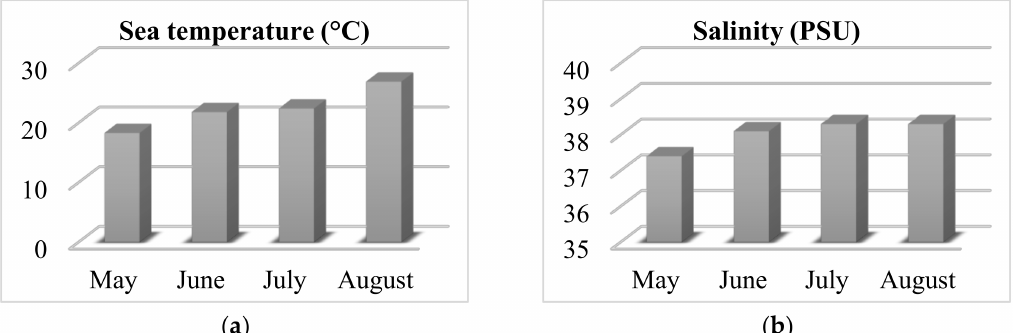
Figure 3. Sea parameters during the algal material sampling; ( a ) Temperature and ( b )